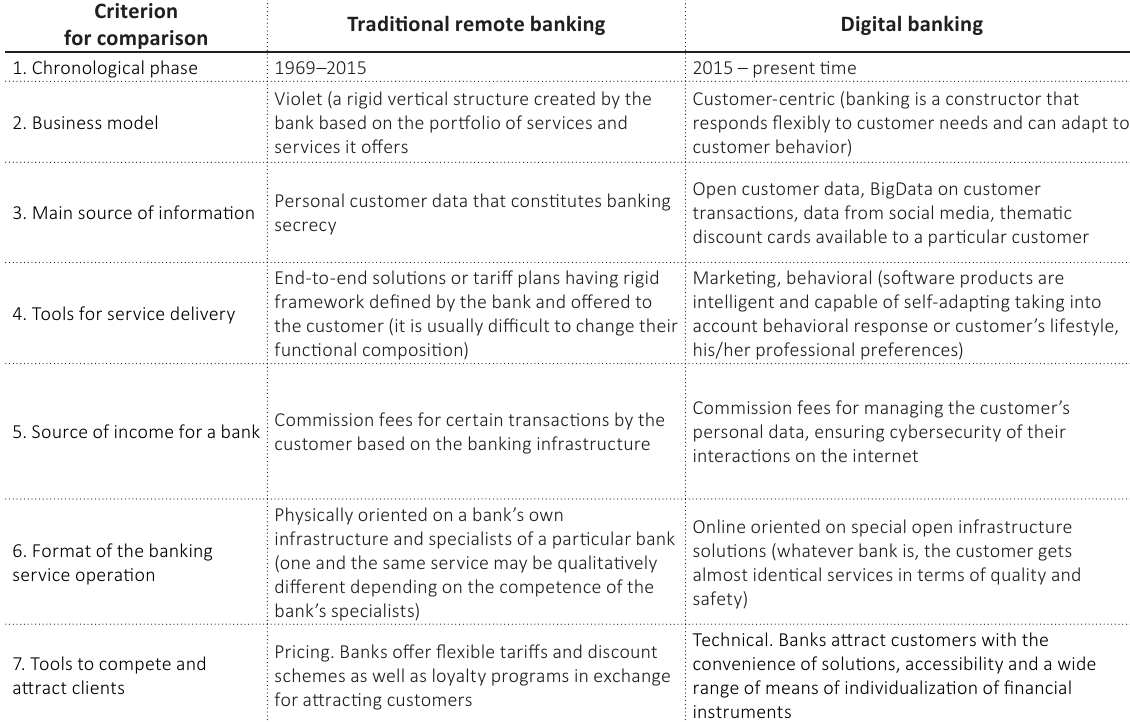
Table 1. Description of the substantive and methodological differences between traditional remote banking and digital